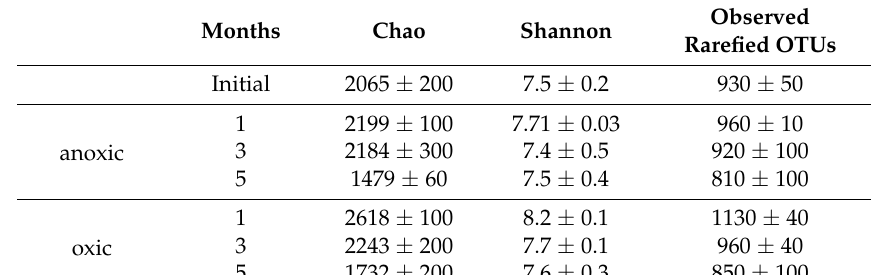
Table 3. Alpha rarefaction showing average diversity metrics for the time points of each incubation with the standard deviation between the replicates and the iterations shown.